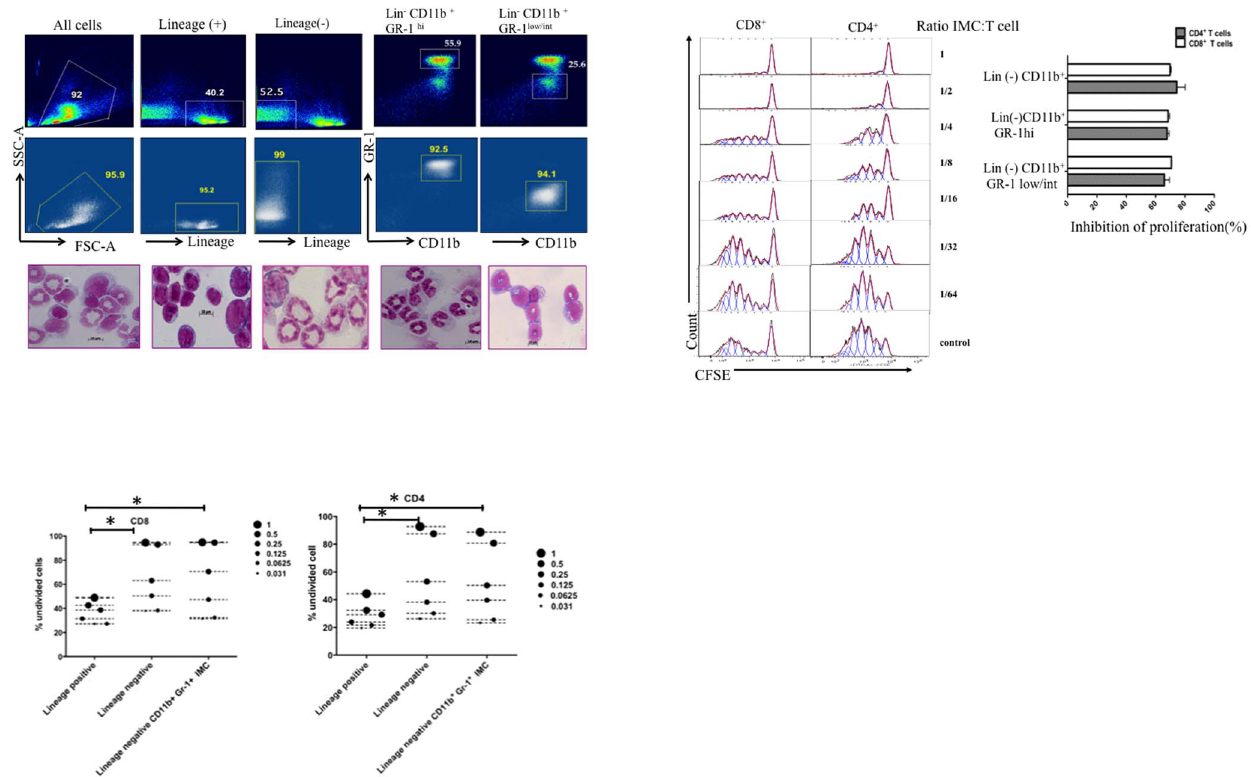
Figure 1. Suppressor activity of bone marrow myeloid cell subsets. Single cell suspensions of bone marrow were prepared from C57BL/6 mice and stained with anti-CD11b APC-Cy, anti GR-1 FITC, and lineage PE cocktail. Lineage ( + ), lineage ( 2 ), CD11b + GR-1 hi and CD11b + GR-1 low/int BM populations were isolated by FACS. A) Pre sort gates (upper panels). Reanalysis of sorted populations (middle panels). Lower panels represent morphology of Giemsa stained cells (63 6 magnification). B) CFSE fluorescence histograms of viable 7-AAD ( 2 ) MACs purified T-cells co-cultured with different CD11b + GR-1 + /splenocyte ratios (left panel). C) Comparison of the percentage inhibition of proliferation of T-cells co-cultured with CD11b + GR-1 hi , CD11b hi GR-1 low/int and lineage ( 2 ) CD11b + cells (ratio1/1). Bars represent the mean values 6 SD of two experiments. D) Comparison of the potency of sorted BM fractions of IMCs (mix of both CD11b + GR- 1hi , CD11b hi GR-1 low/int ) on percentage of undivided CFSE labeled T-cells following 5 days co culture in the presence of anti-CD3/CD28 beads, and IL-2. The legend shows the ratio of sorted IMC: T-cells with the size of the symbol representing the relative numbers of IMCs in the culture. P value , 0.05 represent significant difference for both percentage of undivided CD4 + and CD8 + T-cells between lineage positive with lineage negative and CD11b + GR-1 + IMCs at (IMC: T ratios of 1 and 0.5). Data from a single experiment, representative of 4 individual experiments, is shown.